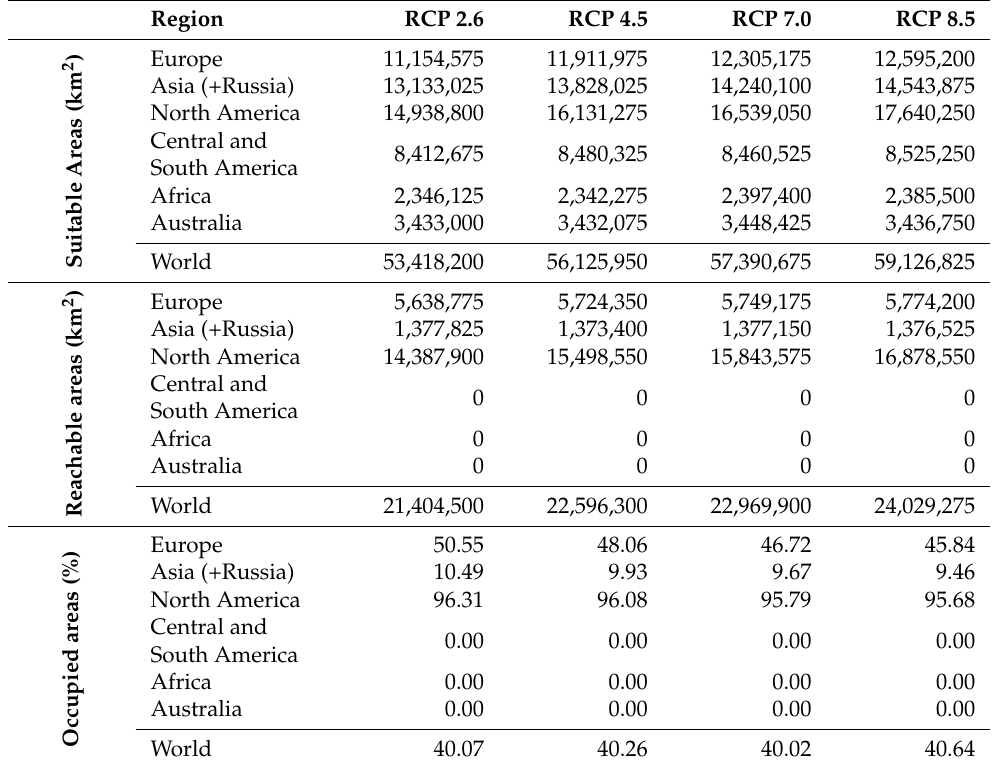
Table 4. Future distribution (km 2 ) of the Japanese beetle. Suitable and reachable (from the territory currently occupied) areas were estimated alternatively, excluding and accounting for the dispersal ability of the species. Percentage of reachable suitable areas is also shown.